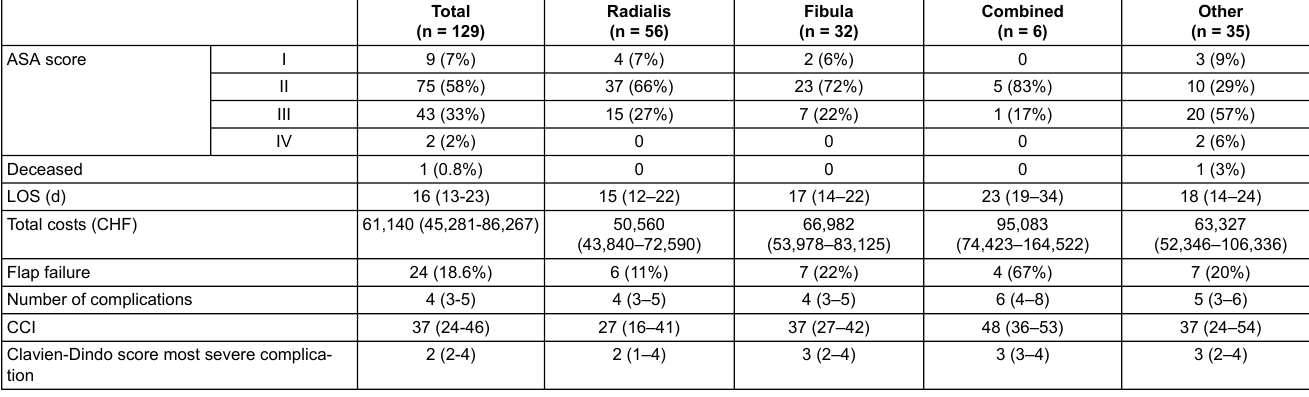
Table 4: Patient outcomes by flap type (radialis vs fibula) (n = 129).